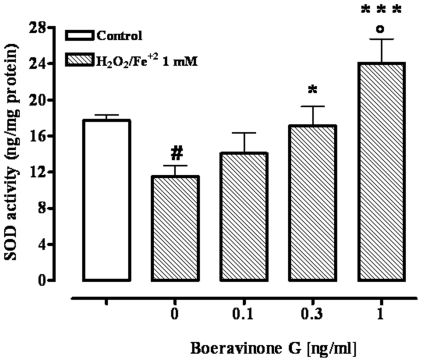
Effect of boeravinone G (0.1–1 ng/ml) on superoxide dismutase (SOD) activity.SOD activity was evaluated in Caco-2 cells exposed to Fenton's reagent (H2O2/Fe2+ 1 mM) without or with boeravinone G (0.1–1 ng/ml). Data represent mean ± SEM of 4 experiments. #p<0.001 vs control (vehicle); *p<0.05 and ***p<0.001 vs H2O2/Fe2+ alone; °p<0.05 vs control.